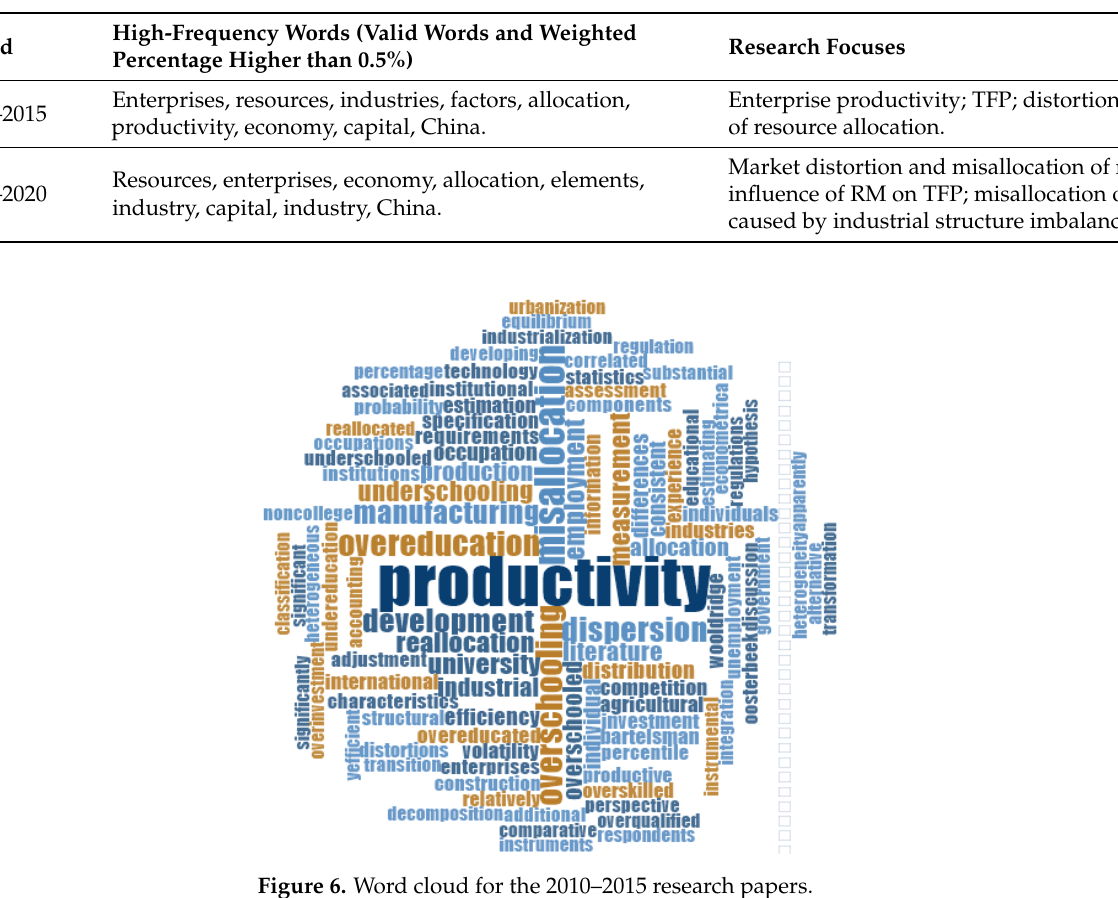
Table 5. Most popular research